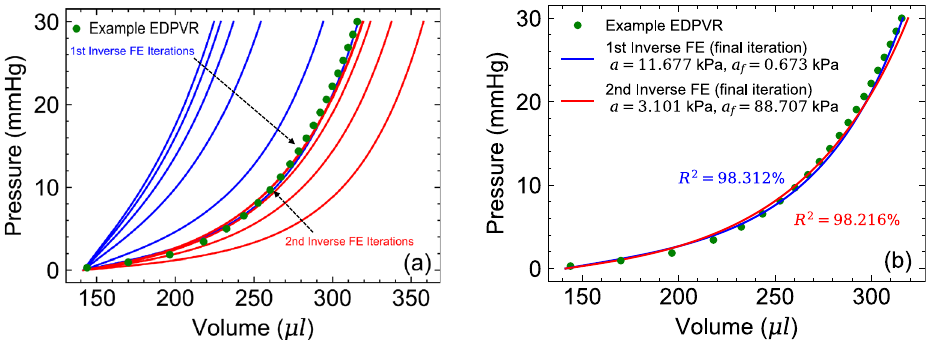
Figure 6. Constitutive parameter identifiability issue with using EDPVR as the target: ( a ) inverse FE model iterations to fit an example EDPVR starting from two different initial guesses for { a , a f } ( b ) Resulting fits at the final iteration leading to different values for { a , a f } with equally good fits. Parameters b = b f = 5 were kept constant during the optimization.